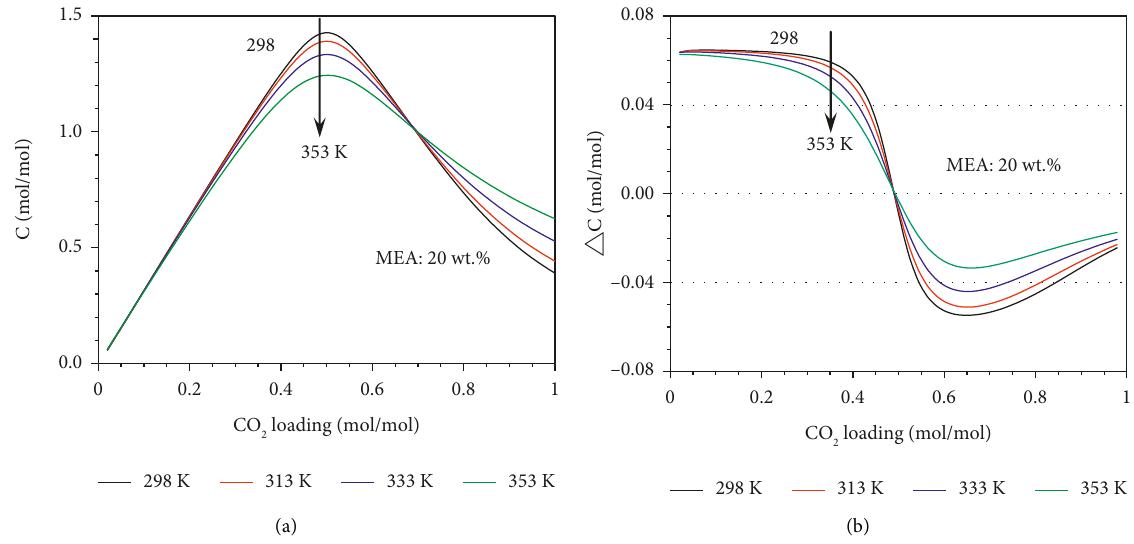
Figure 7: (a) RNHCOO − equilibrium concentrations at different temperatures as a function of CO of RNHCOO − equilibrium concentrations as a function of CO 2